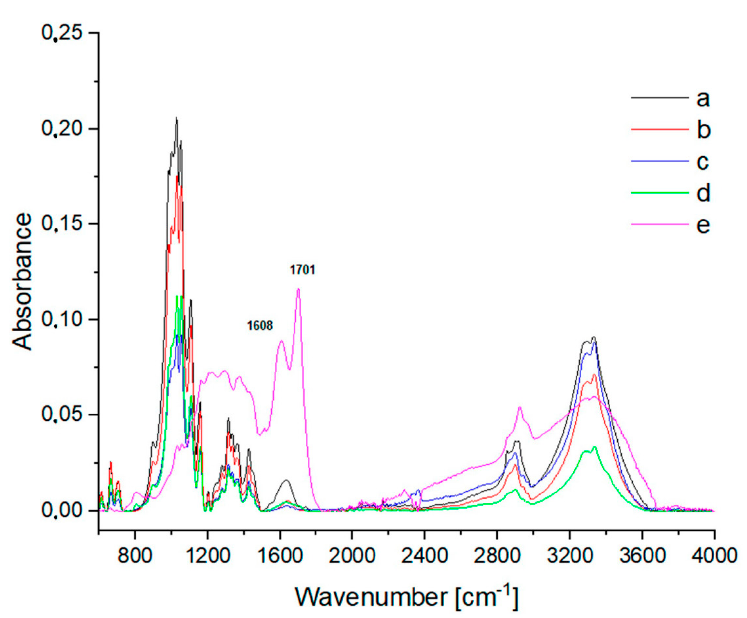
Figure 4. IR spectra of ( a ) washed cotton and cotton treated for 2 h with 2% H 2 SO 4 at various temperatures: ( b ) 120 °C; ( c ) 140 °C; ( d ) 160 °C; ( e ) 200 °C.